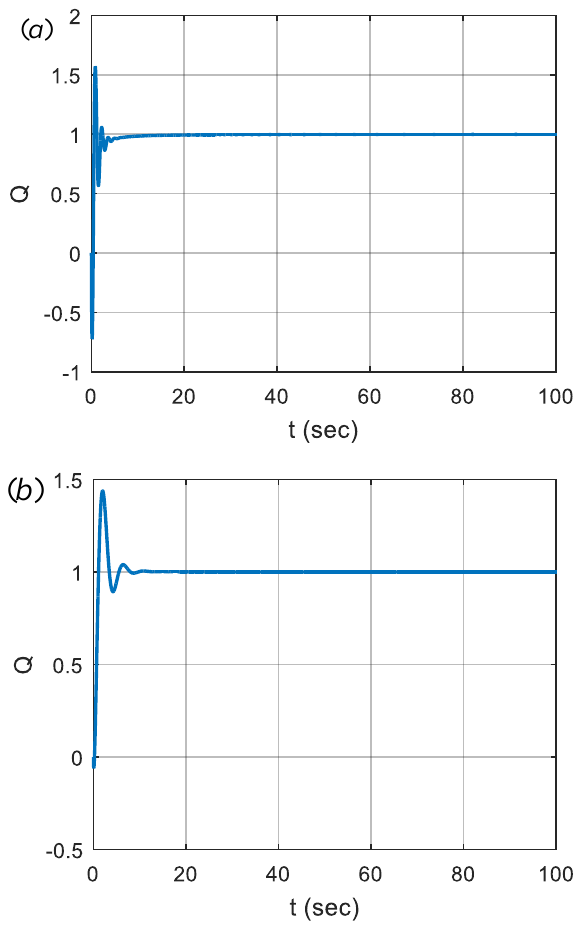
Figure 7. Step response of the stabilized FOPID control system for nominal plant function G m ( s ) ; ( a ) FOPID controller and ( b ) PI controller.